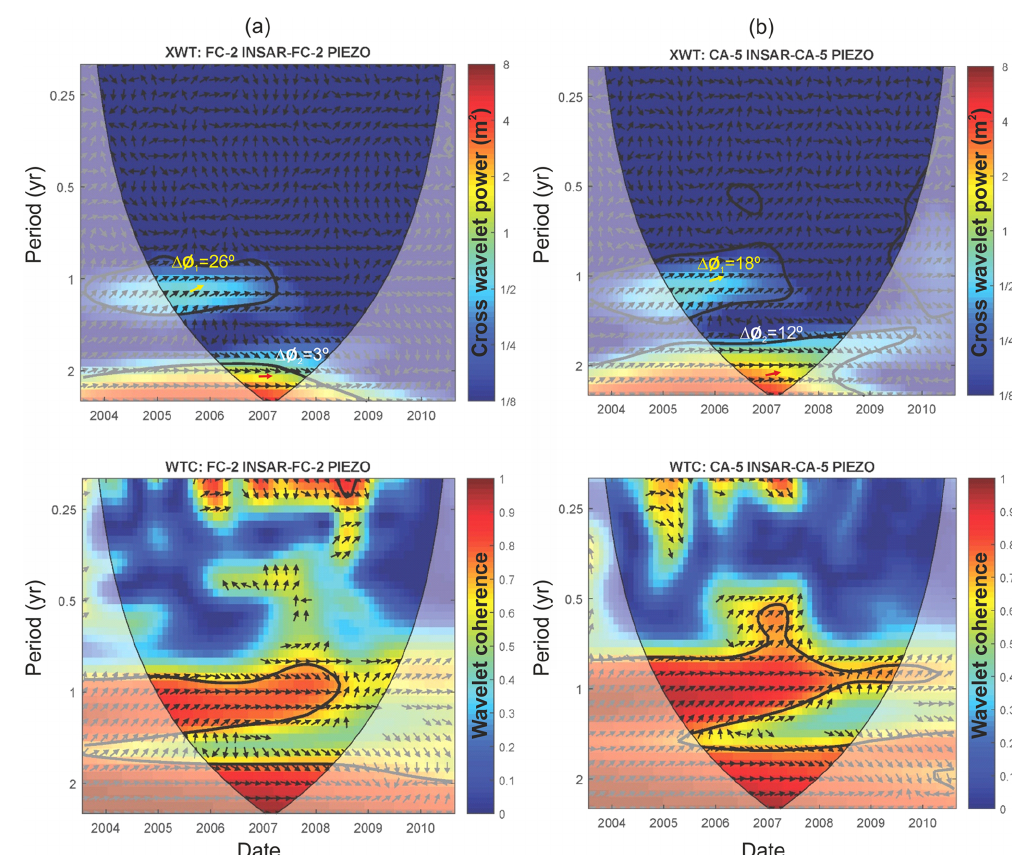
Figure 4. XWT cross-wavelet power spectra and WTC wavelet coherence of InSAR displacements and piezometric data time series from two wells (a) FC-2 and (b) CA-5 in the TDAM. Colour scale is described in Fig. 2